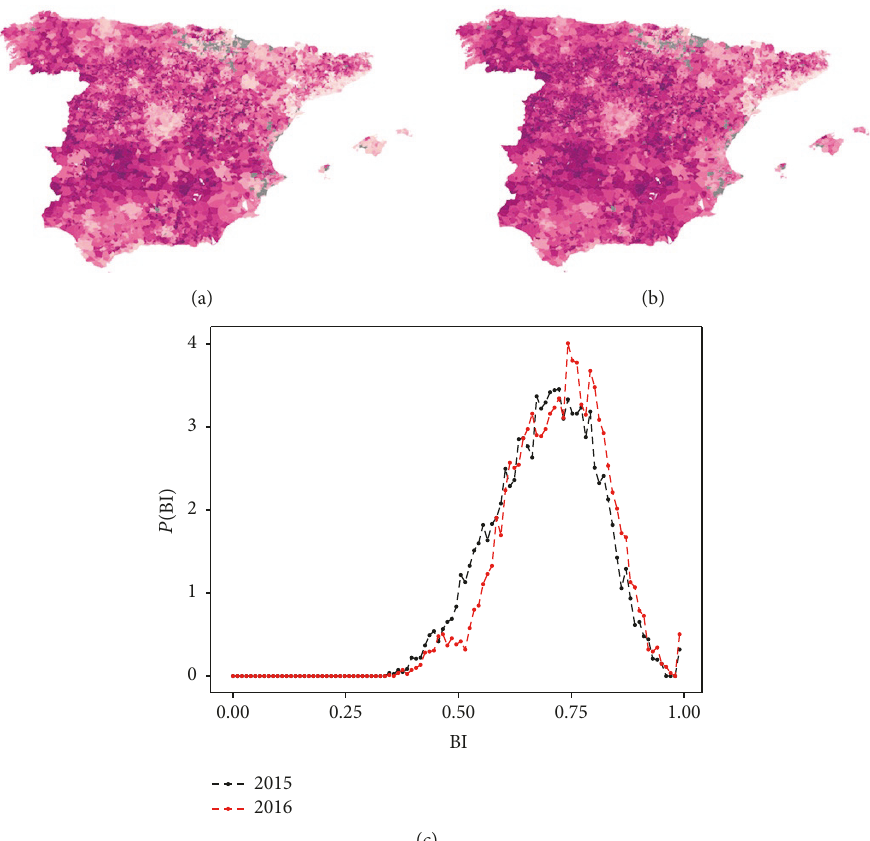
Figure 2: (a, b) Heat map of the bipartisanship index (BI, see the text) at the municipality level (the darker and the larger the BI is, the more bipartisan the system is) for 2015 elections (a) and 2016 elections (c). One can see that overall bipartisanship decreases from 2015 to 2016 and that bipartisanship breakdown is more acute closer to important, cosmopolite cities (e.g., Madrid and Barcelona). (c) Frequency histogram of BI for 2015 and 2016. In 2015, the distribution has a clear Gaussian shape and such shape is slightly perturbed in 2016.